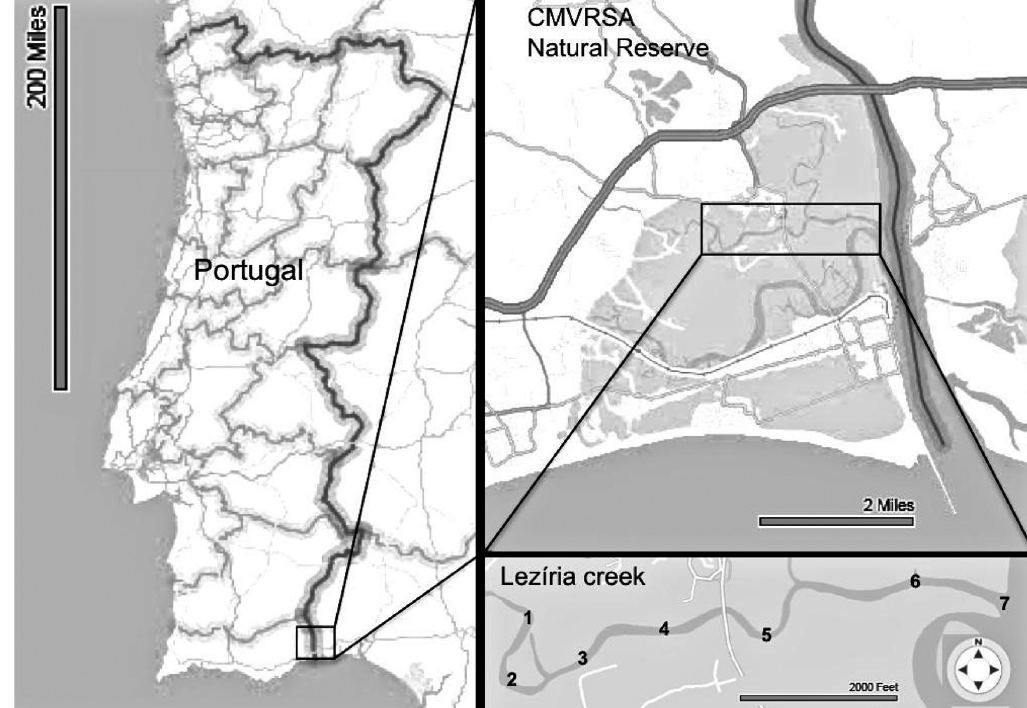
Fig. 1. – Locations of sampling stations along Lezíria creek in Castro Marim and Vila Real de Santo António Natural Reserve (RNCMVRSA), Portugal. Shaded area indicates the extent of the Natural